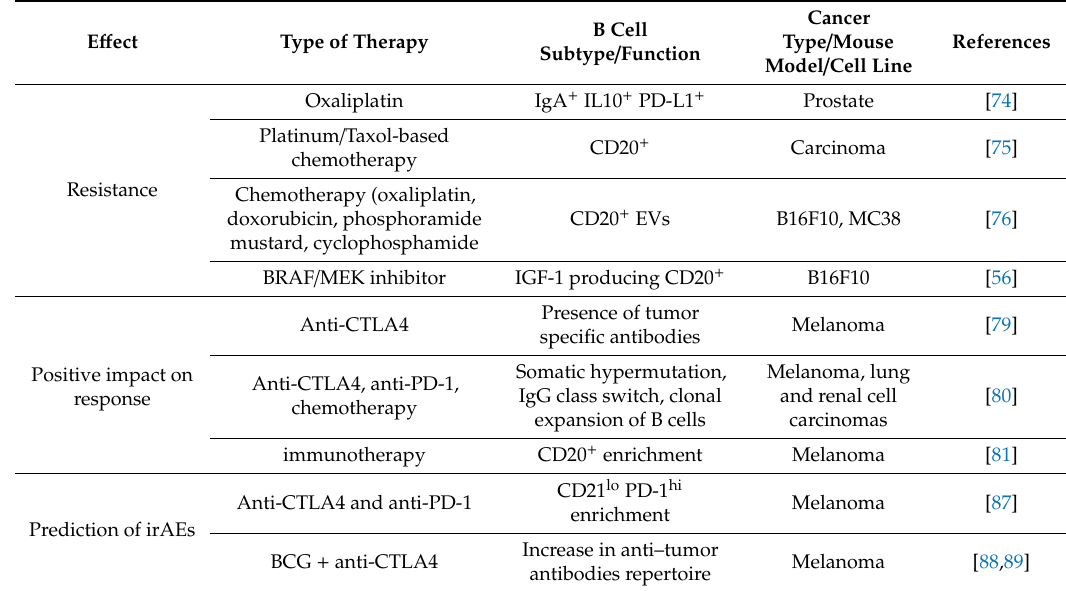
Table 2. The roles of B cells in response to current therapies are summarized accordingly to the type of therapy and B cell